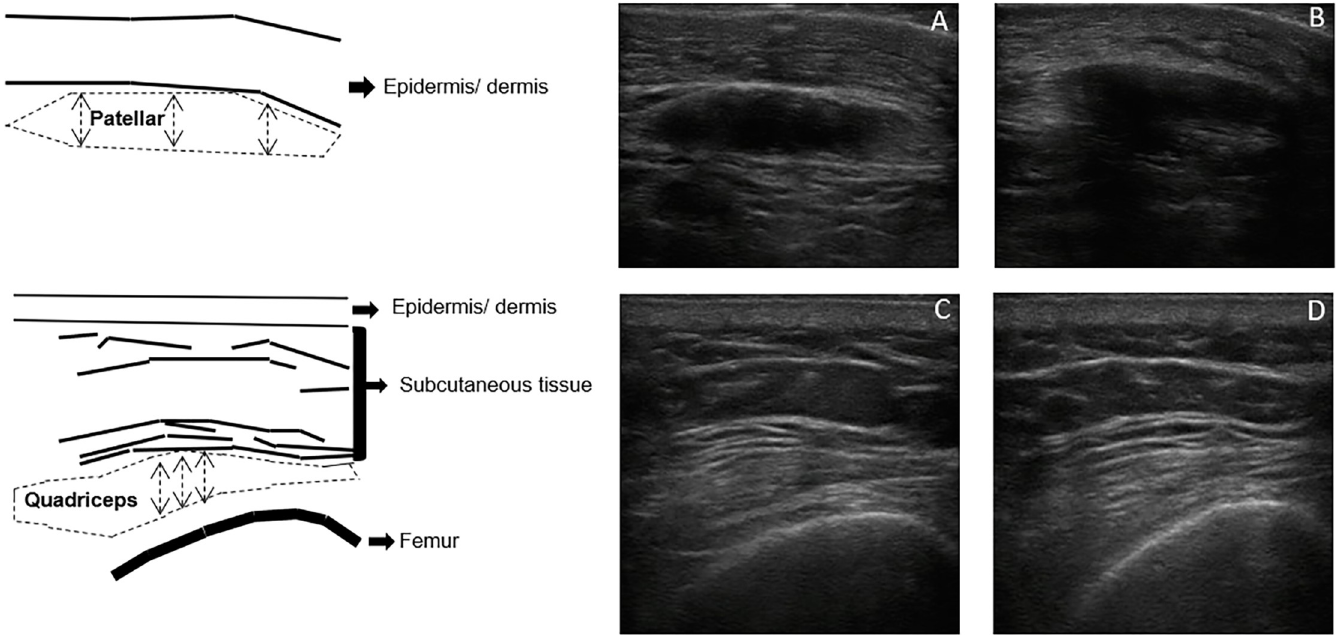
Fig 1. Sonographic appearance of patellar and quadriceps tendons. Example of ultrasonography scans of the patellar (upper part) and quadriceps (lower part) tendons. The left panel depicts the different structures schematically. The dotted line represents the region of interest for the cross-sectional area and echogenicity of each tendon. Tendon thickness is symbolized by the dotted arrows. Tendon scans were conducted with a 4.9 cm depth. For example, considering the qualitative analysis performed in this study, A and C were qualified as “good” images; B and D were qualified as “bad”